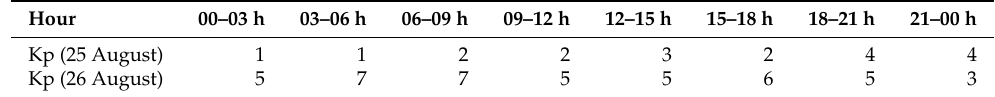
Table 2. Hourly Kp for the 25–26 August